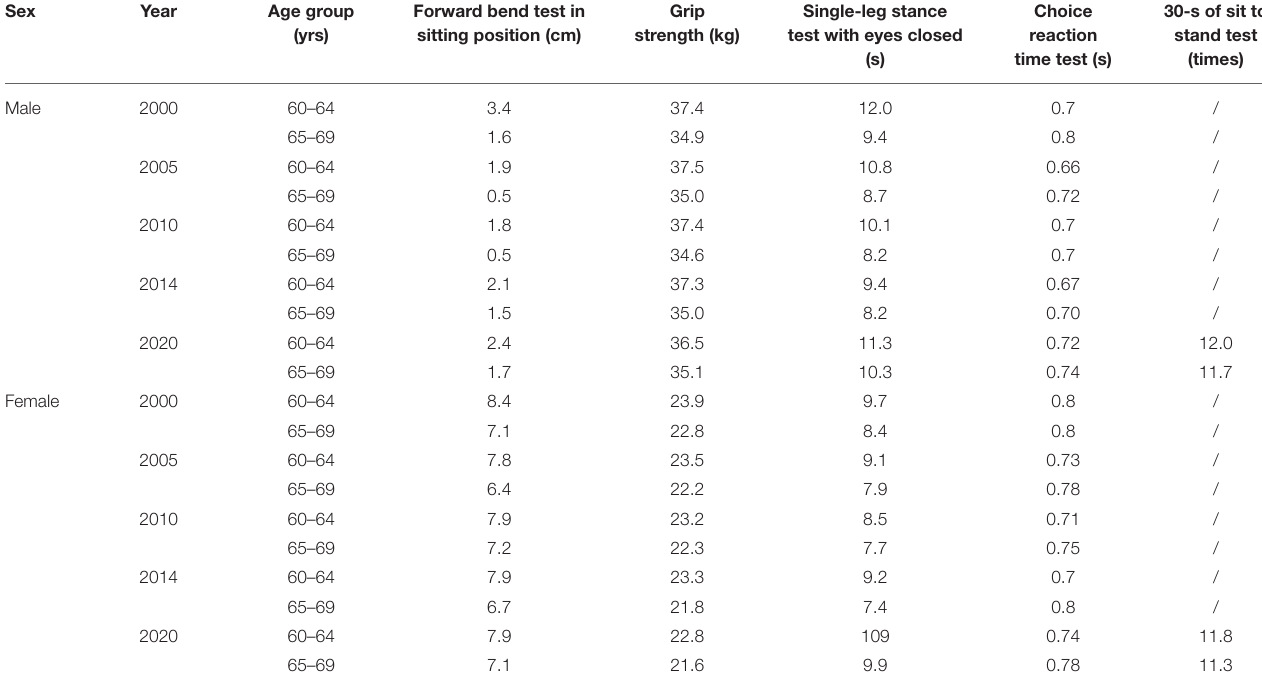
TABLE 4 | Indicators of physical function average test results in national physical fitness